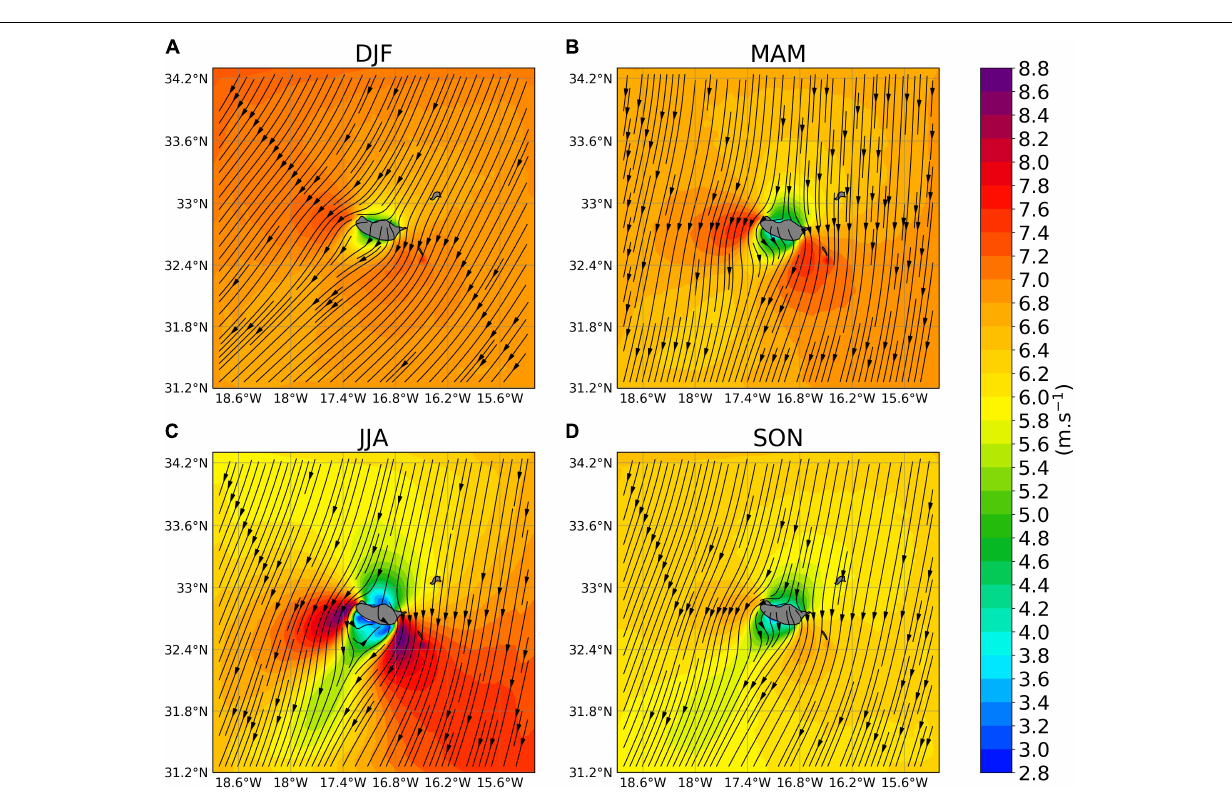
and lower height PBL in summer, lowering from about 1,700 m in winter (DJF) to about 1,000 m in summer (JJA). The lower summer value is below the height of the main island plateau, implying the need for flow deflection around the island with streamline squeezing near